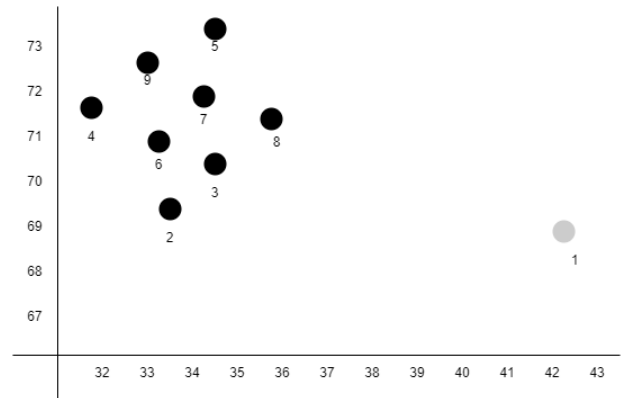
Figure 5. Point ranking in the sample